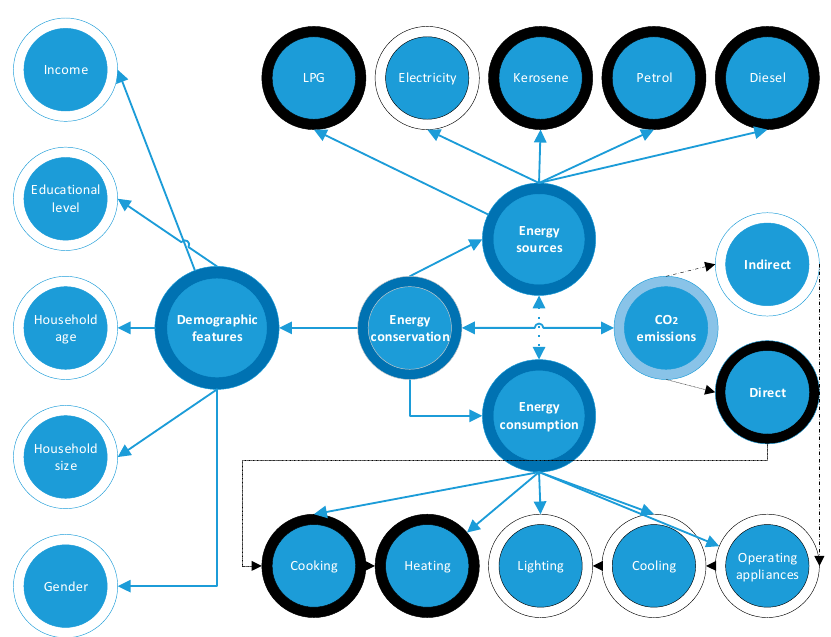
Figure 8. Influential factors on the CO 2 emissions from Iranian households energy consumption [28]. Reproduced with copyright, Elsevier.